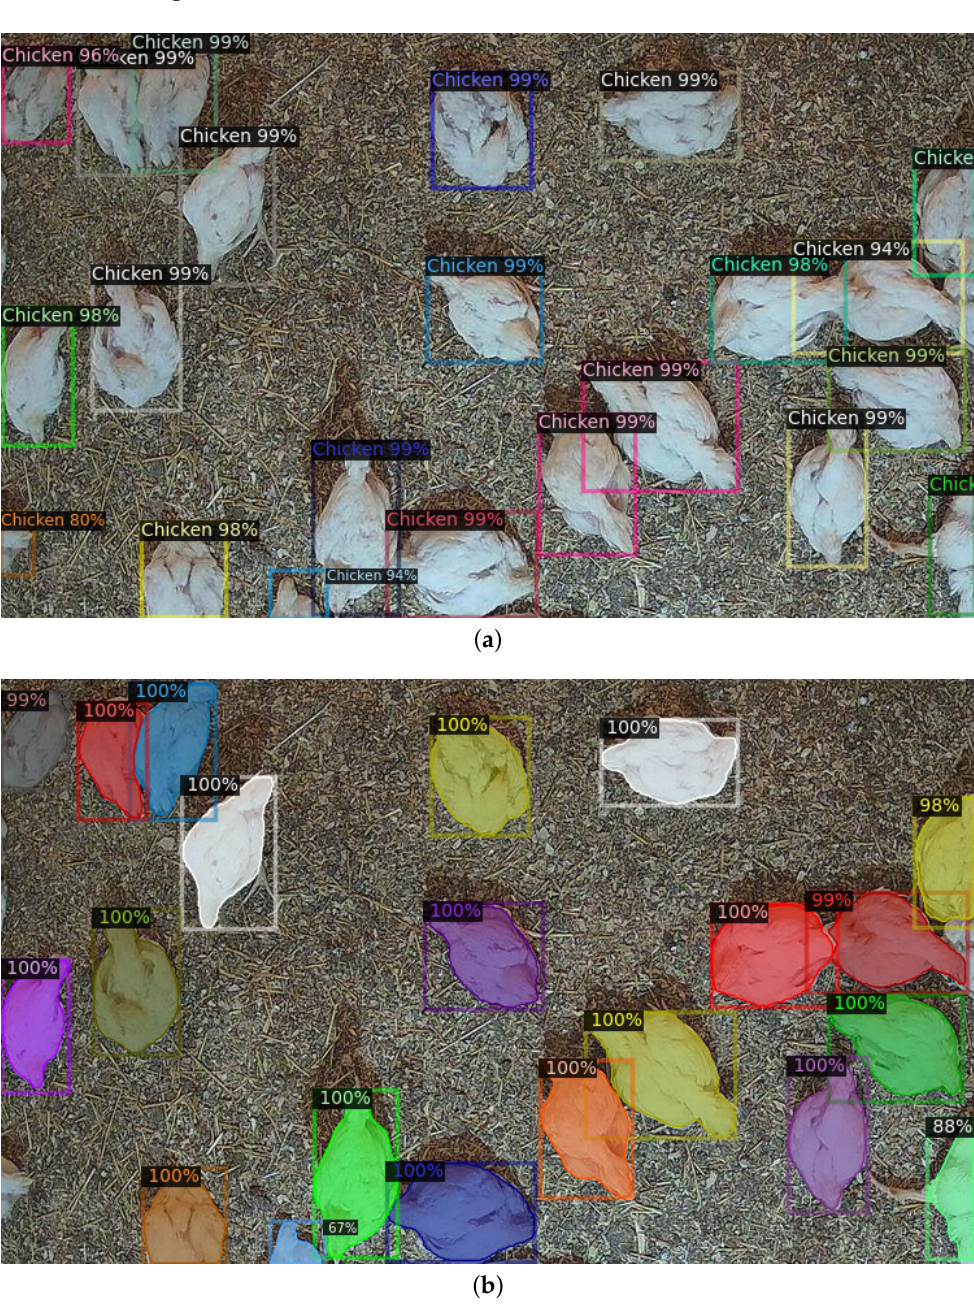
Figure 6. Field verification and validation using the models on the edge AI device at the end user site: ( a ) object detection ( b ) instance